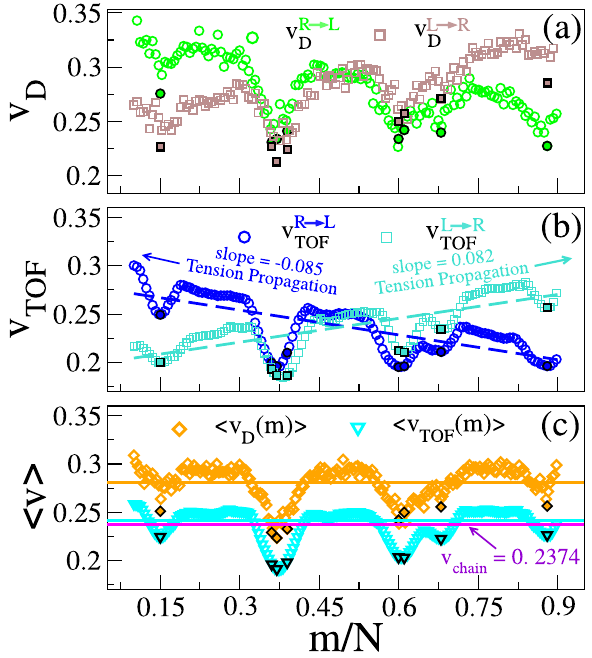
Figure 2. ( a ) Dwell velocities and ( b ) TOF velocities of the monomers during R → L (blue circle) and L → R (turquoise square) translocation. Eight tag velocities are marked by the filled symbols. The dashed lines (turquoise and blue) indicate the directions of the tension propagation for L → R and R → L respectively. ( c ) Directional averaged dwell velocity and TOF velocities are represented with orange diamond and turquoise inverted triangle. The solid orange horizontal line represents average dwell velocity and the cyan line represents the average tof velocity of all monomers respectively. The average velocity of the entire chain is represented by the violet